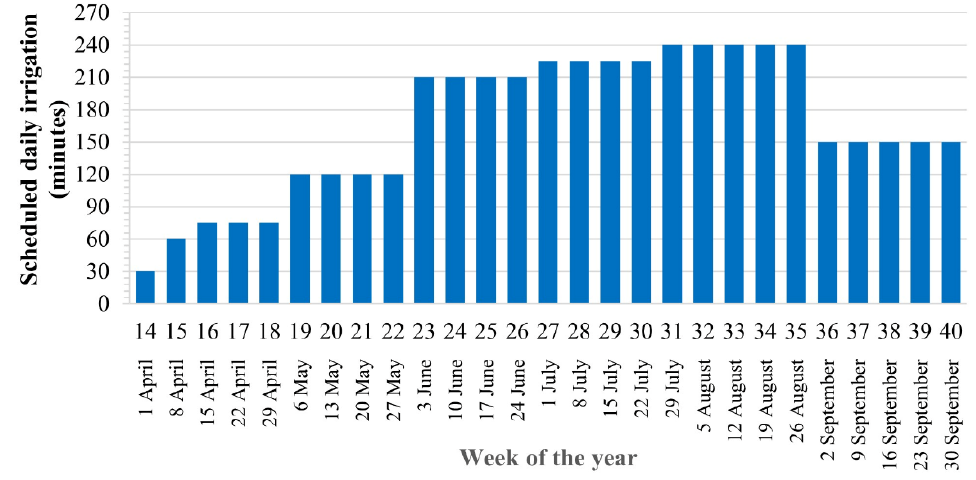
Figure 6. Weekly programming of gross daily irrigation, in minutes, for the irrigation season be ‐ tween April and September. April and